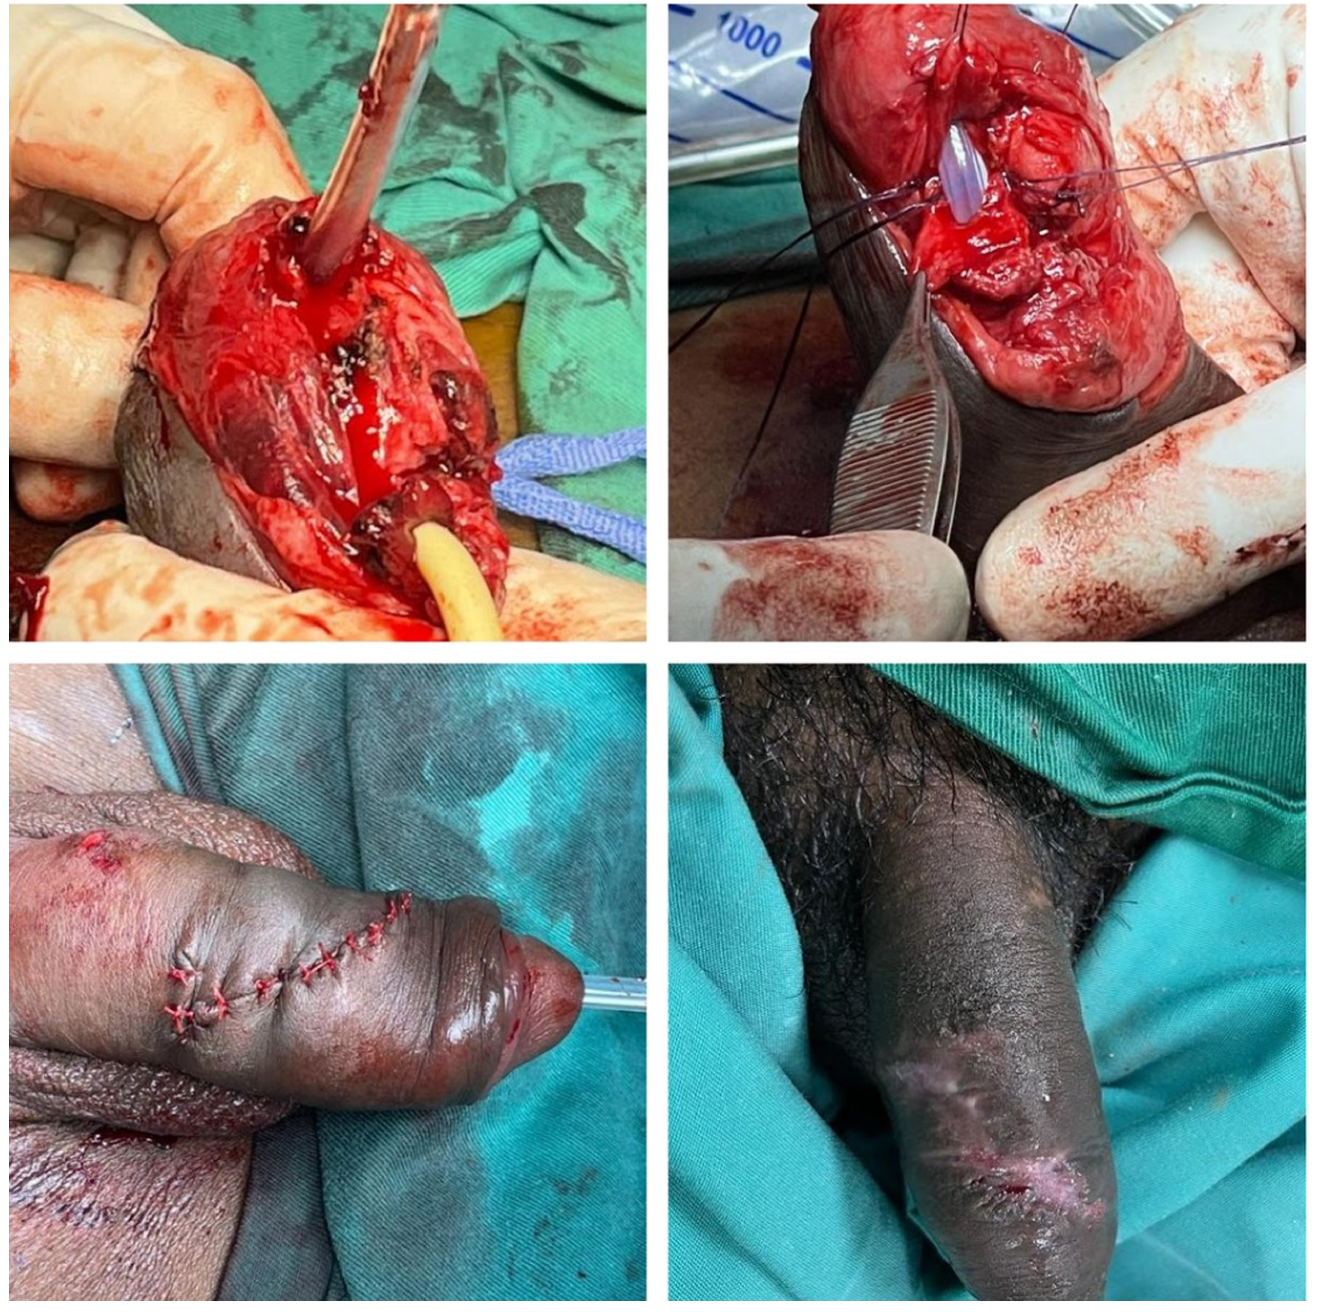
Figure 3. This patient sustained transacted penile urethral with the breach at tunica of corpus cavernosum. Primary repaired done and recovered